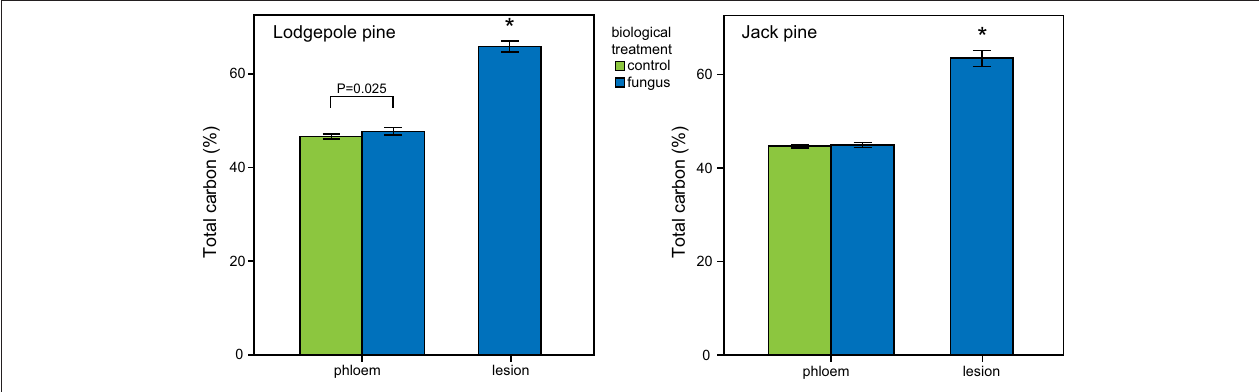
FIGURE 8 | Total carbon content (mean ± CI) in lodgepole ( P. contorta ) and jack pine ( P. banksiana ). Lesion tissue contains significantly more total carbon (marked by asterisk, independent t -test, p < 0.05 ) than phloem in both species. Additionally there is a significant difference in total carbon in lodgepole pine phloem caused by biological treatment (ANOVA, P < 0.05